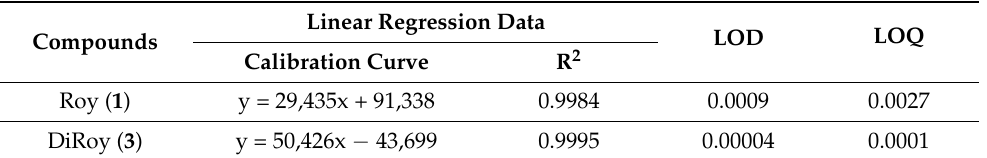
Table 1. Quantitative analysis of compounds ( 1 ) and ( 3 ) in Plectranthus hadiensis extracts and fractions using HPLC–DAD.